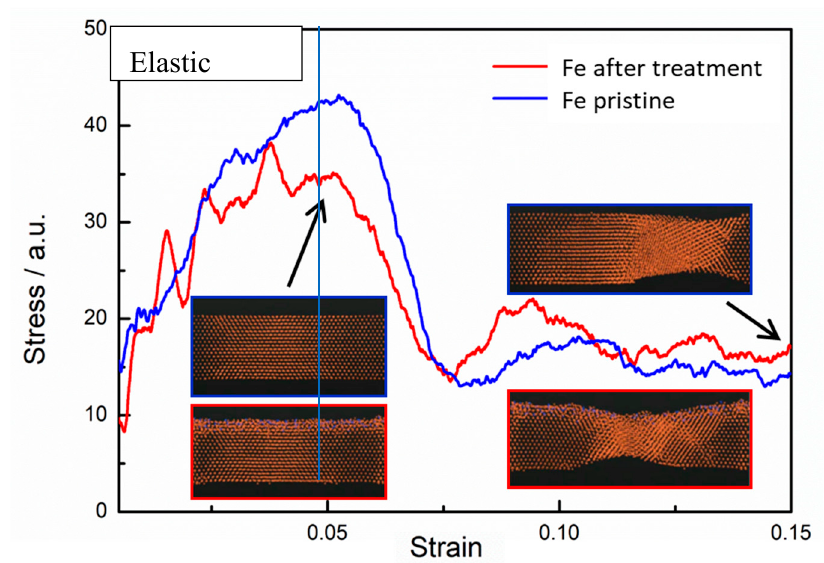
Figure 12. Uniaxial tensile stress-strain curves of iron with and without N plasma treatment.